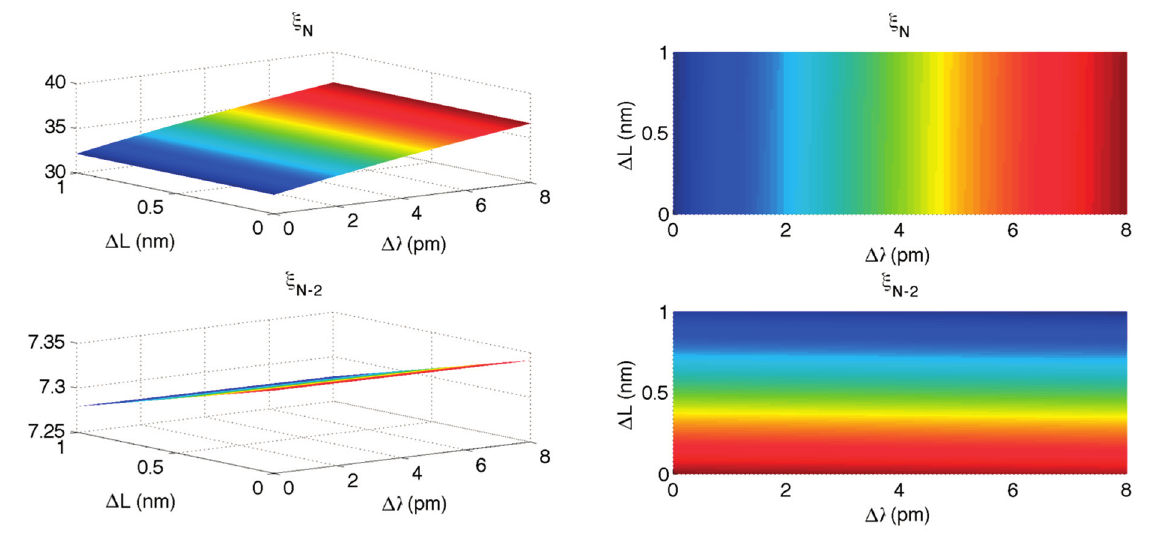
Figure 13. KLT applied to short-range interrogation of FBG/FPI. The upper charts shows the high-rank eigenvalue ξ N as a function of FBG wavelength shift Δλ and FPI cavity length expansion Δ L ; the lower charts show the eigenvalue ξ N − 2 as a function of Δλ and Δ L. Left charts plot the full 3D view; right charts show the 2D